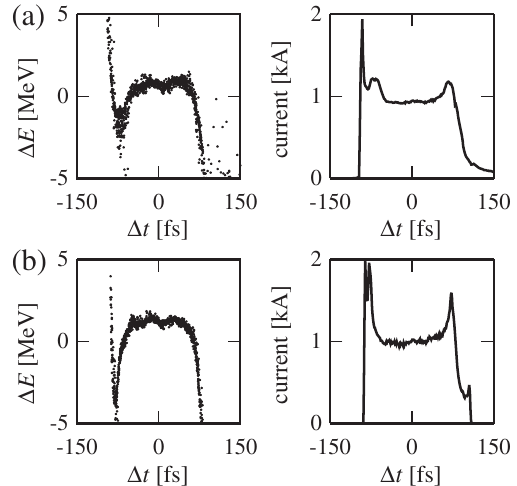
FIG. 9. Simulations of microbunching from shot noise. For on- crest acceleration of the compressed bunch, the left-hand plots show the longitudinal phase space while the right-hand plots show 200-bin current histograms at the exit of the beam spreader. (a) Dechirping by four isochronous arcs at beam energy of 400 MeV. (b) Dechirping by four isochronous arcs at beam energy of 1.7